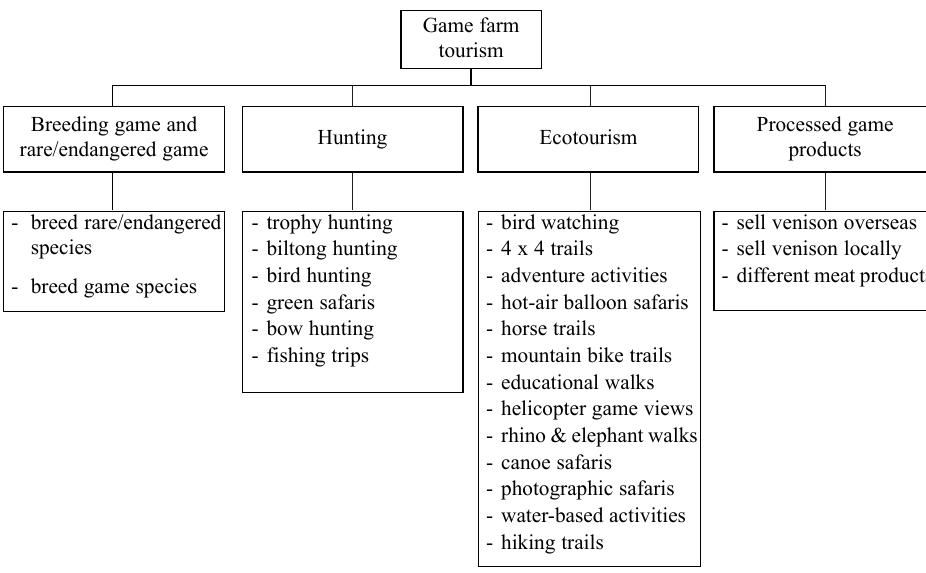
Fig. 1. Four pillars of game farm